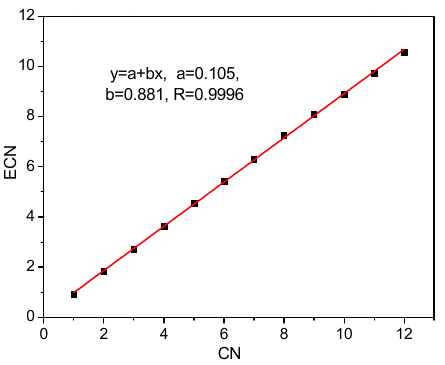
Figure 3. The relationship between effective coordination number and the number of water ligands.